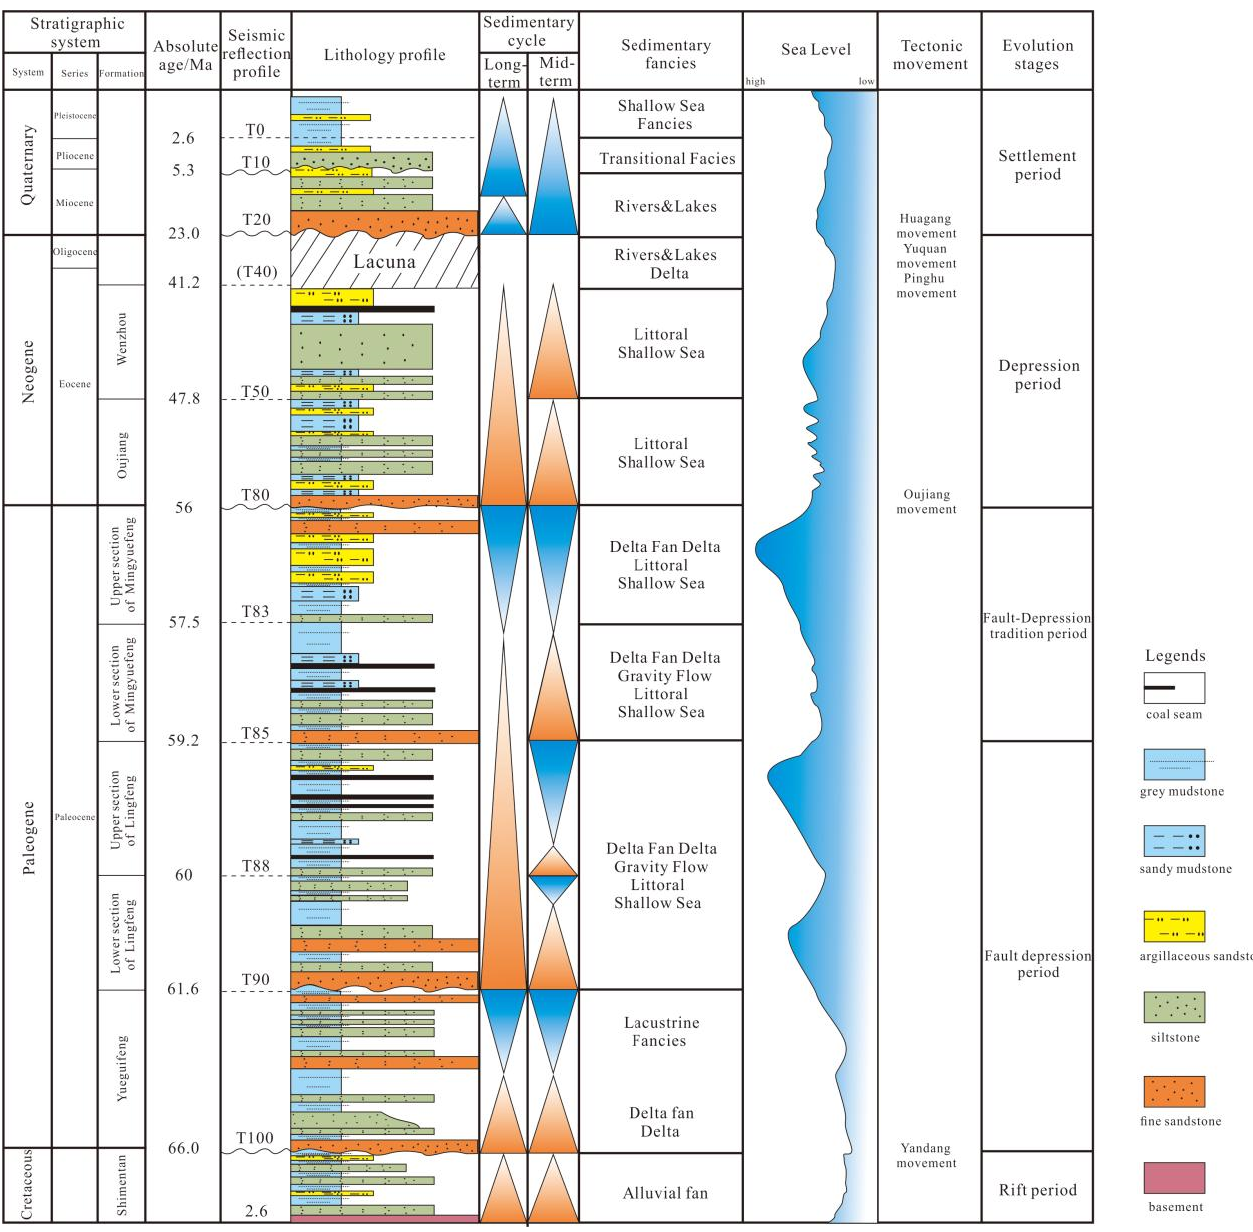
Figure 5. The integrated stratigraphic column of the Lishui Sag.